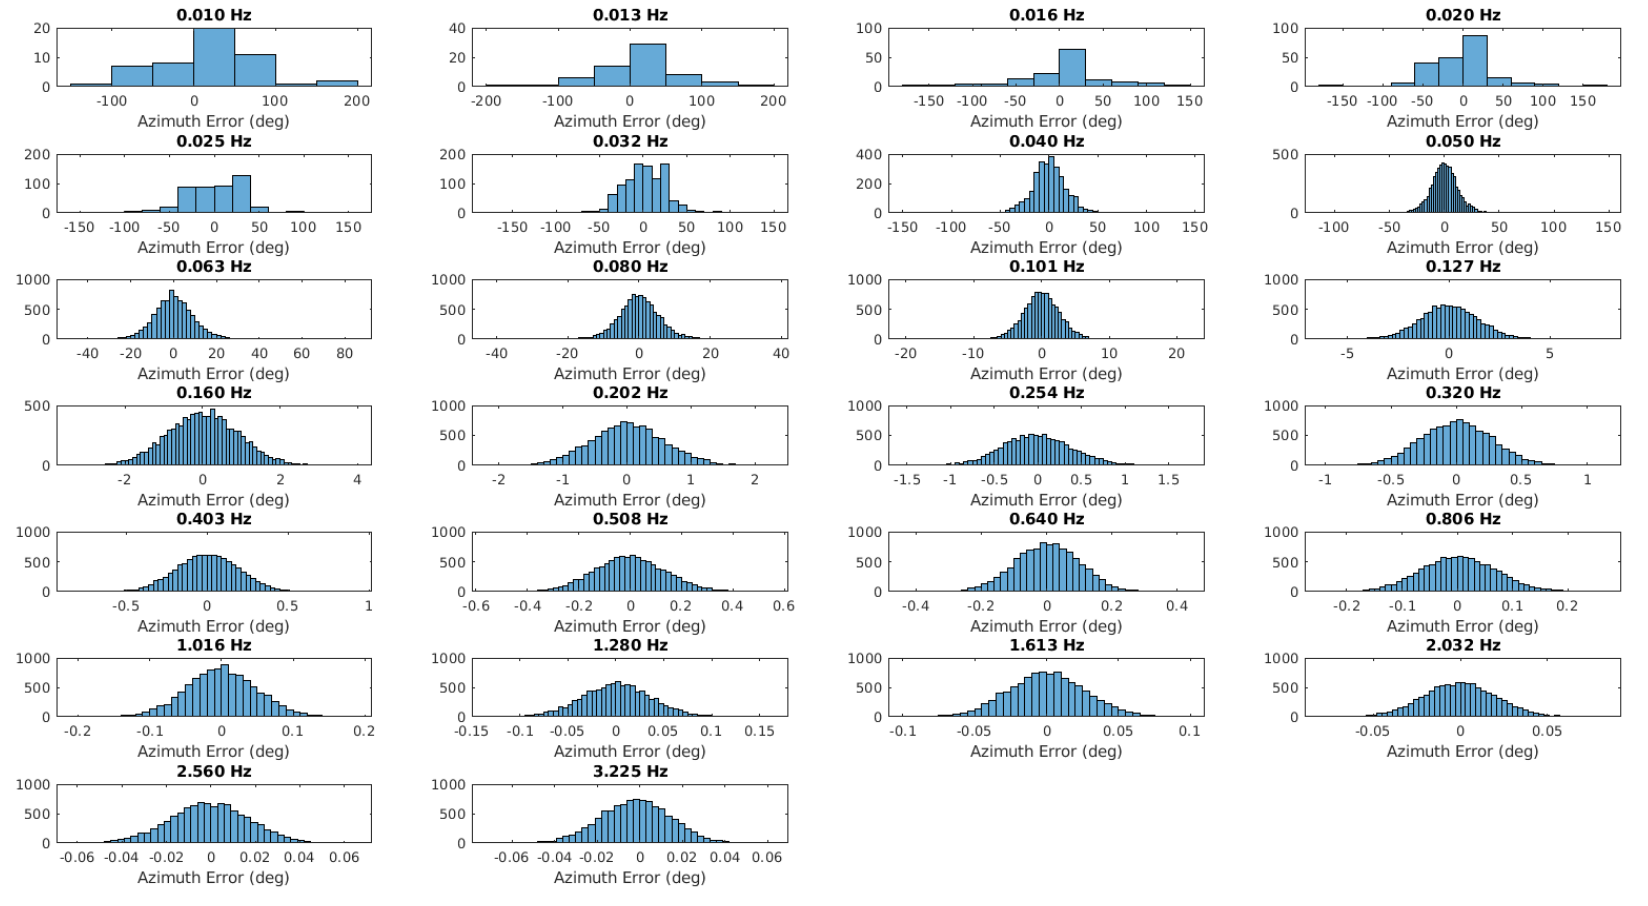
Figure A5. Back azimuth error (bias), SNR = 0 dB, M = 10 4